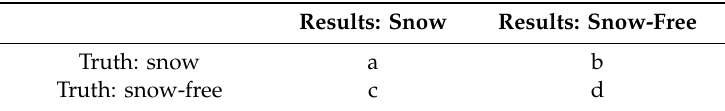
Table 1. Confusion